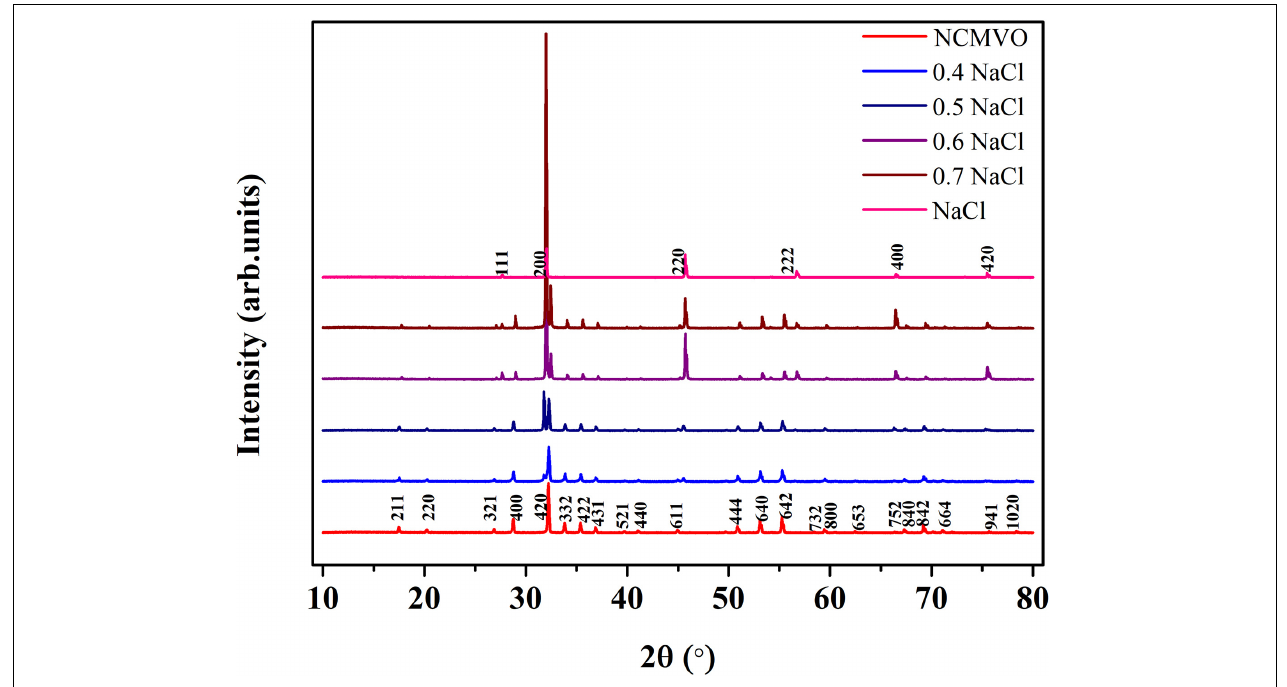
FIGURE 2 | The X-ray diffraction patterns of NCMVO, NaCl and (1 – x ) NCMVO-x NaCl ( x = 0.4, 0.5, 0.6, and 0.7) composites.